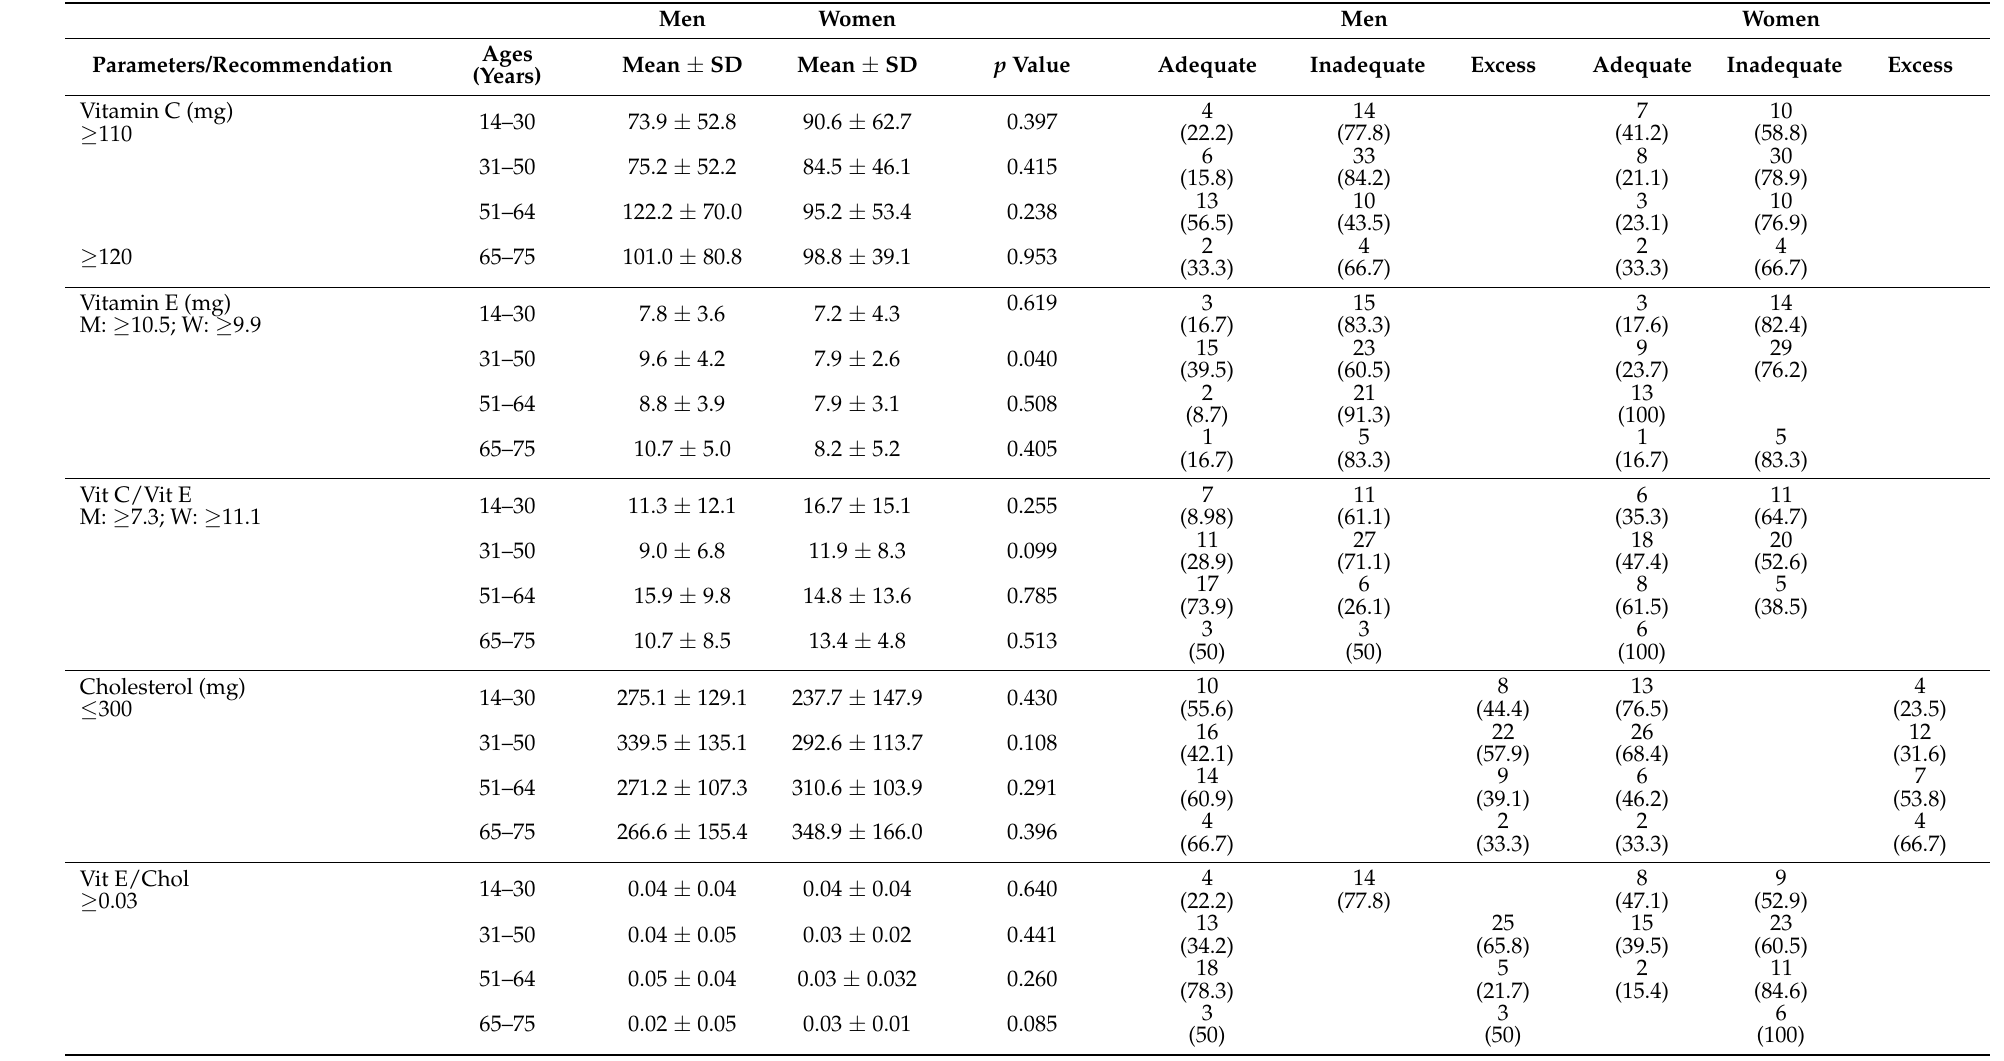
Table 8. Micronutrient and cholesterol intakes and their adequacy in 159 patients with FSHD according to age.